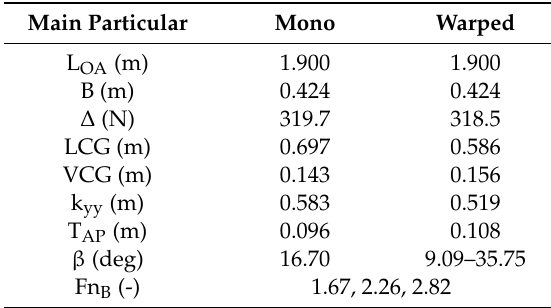
Table 1. Main Particulars of Planing Hulls [5,30].